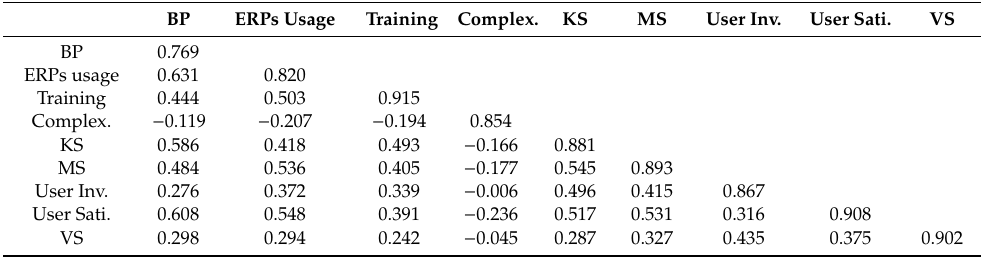
Table 5. Discriminant validity.